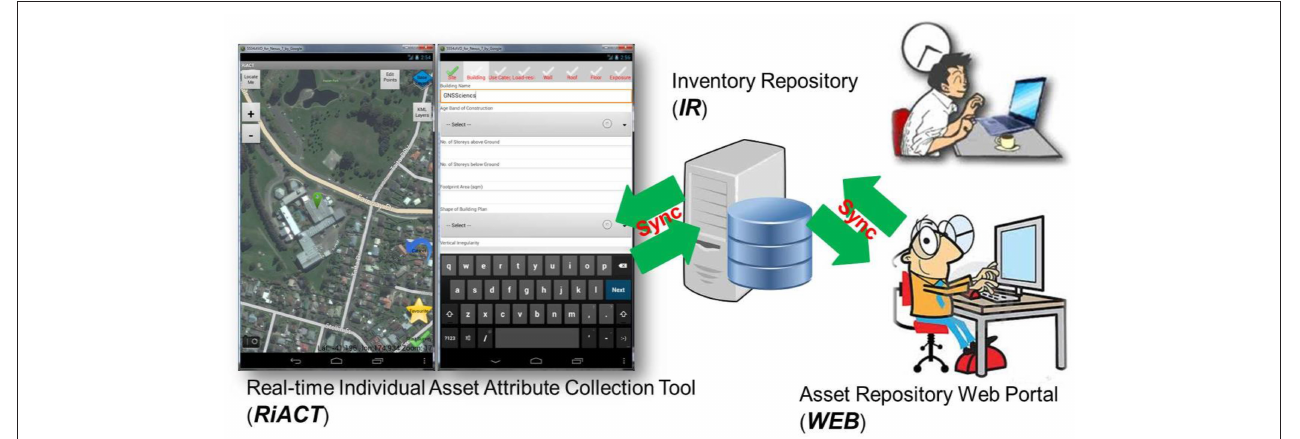
FIGURE 1 | Schematic of the integrated exposure data development